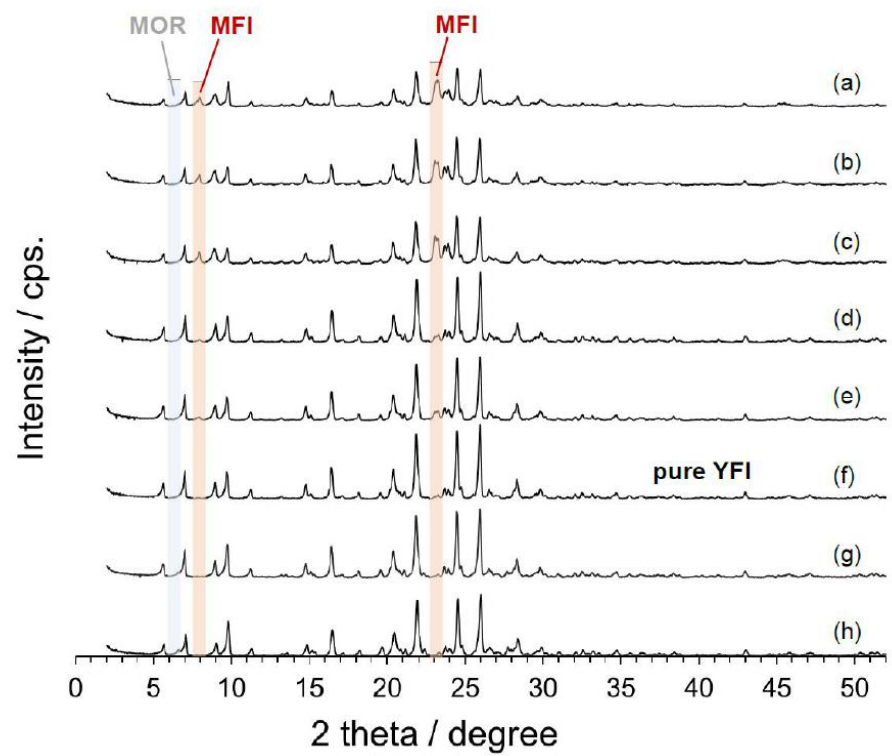
Figure 1. Powder X-ray diffraction patterns showing the effect of water content ( w = H 2 O/SiO 2 molar ratio) in the starting gel on the phase-purity of the product of YNU-5 synthesis. The w values in this series were (a) 10, (b) 9.5, (c) 9, (d) 8.5, (e) 8, (f) 7.5, (g) 7, and (h) 6. The starting gel with molar composition 0.265SiO 2 (from FAU ) – 0.735SiO 2 (from colloidal silica) – 0.025Al 2 O 3 (from FAU ) – 0.17Me 2 Pr 2 N + OH − – 0.15NaOH – 0.15KOH – w H 2 O was heated under static conditions at 160 °C for 4 days. The FAU was HSZ-350HUA (Lot #35UA8301B).